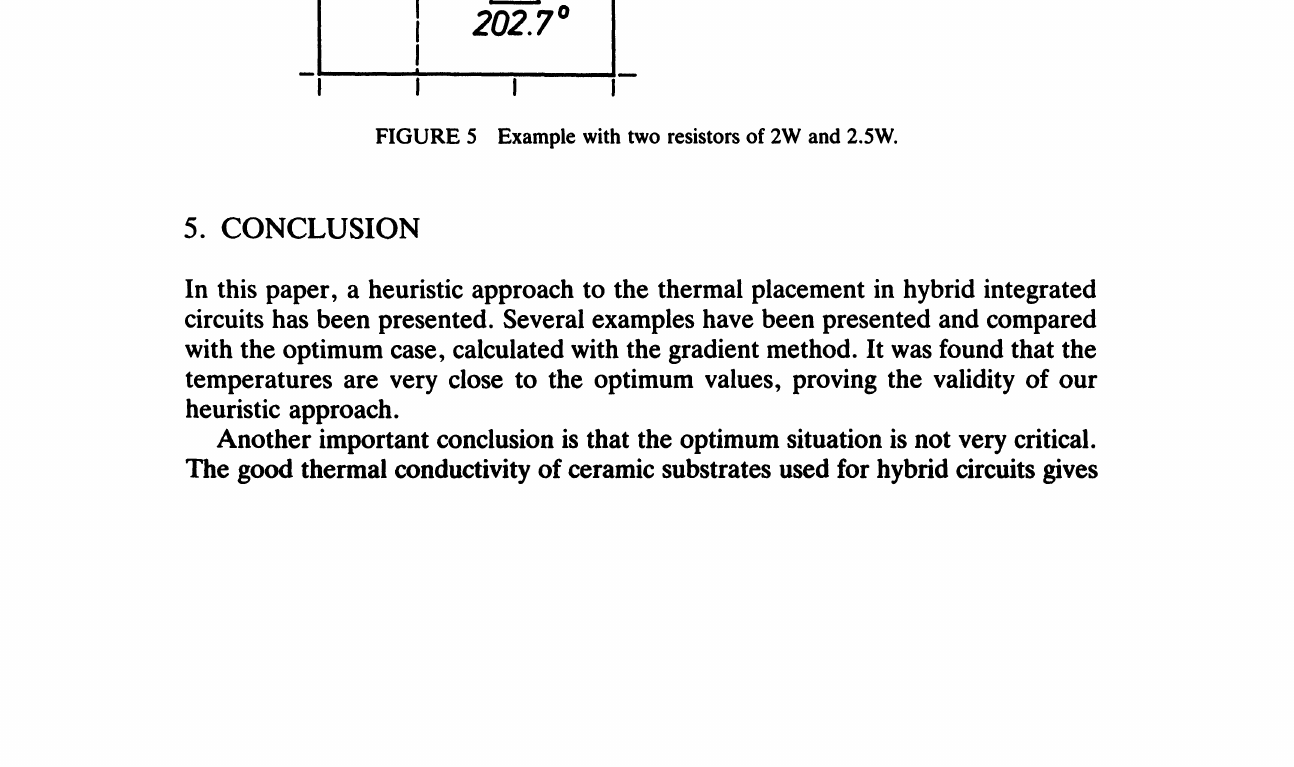
FIGURE 5 Example with two resistors of 2W and